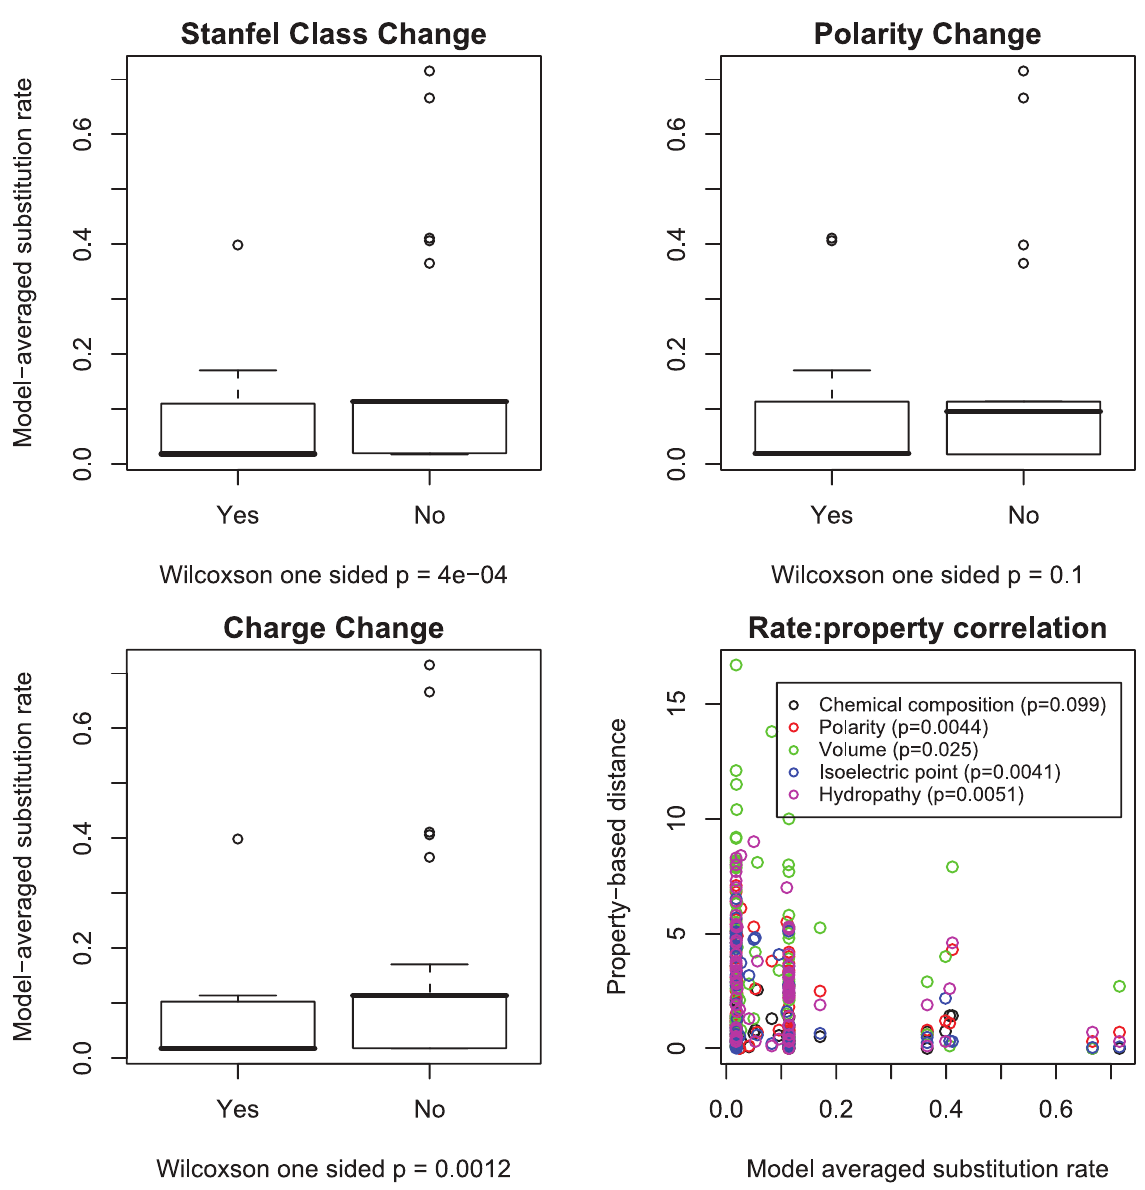
Figure 7. Correlations of lower substitution rates and property preservation in the vertebrate rhodopsin alignment. Model-averaged GA r rates were stratified by whether or not they involved a change in polarity, charge or Stanfel class, the medians of two rate distributions were compared using a one sided Wilcoxon rank-sum test. We further correlated the magnitude of substitution rates with one of five property-based distances between the corresponding residues (defined in [18]) using a one-sided (negative correlation) Pearson product-moment correlation test.